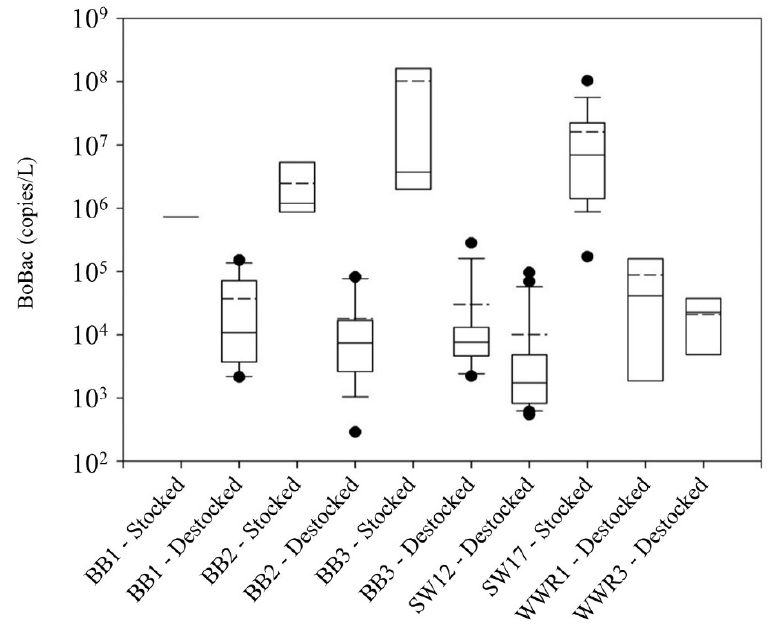
Figure 2. BoBac concentrations (copies/L) in runoff from grazing lands at each site when stocked and